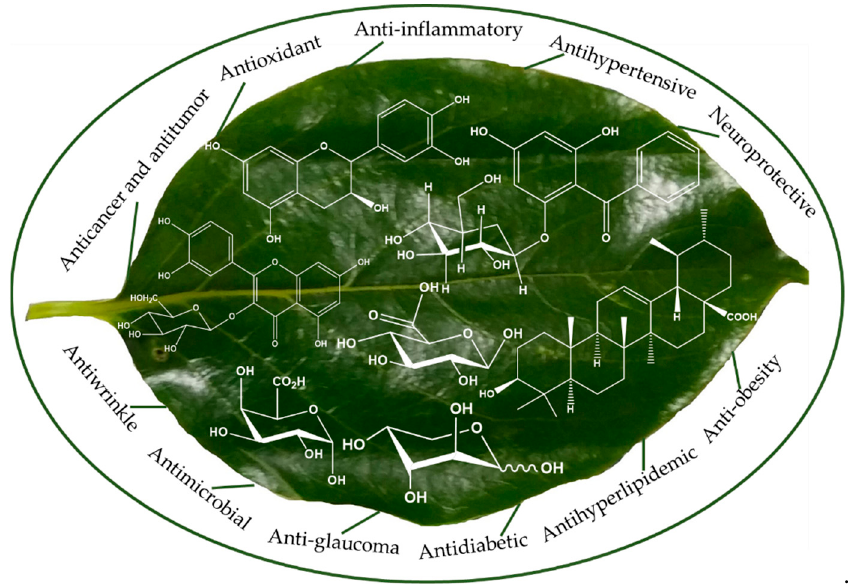
Figure 5. Pharmacological properties of PL. Table 2. Health-promoting properties and mechanisms of actions demonstrated by PL.